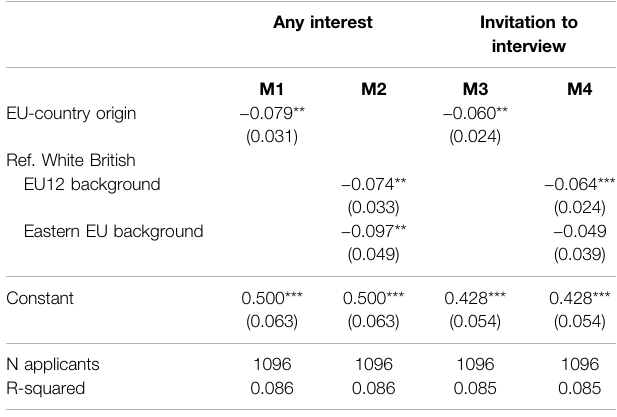
TABLE 3 | Callback gaps between white British applicants and those with EU backgrounds (linear probability